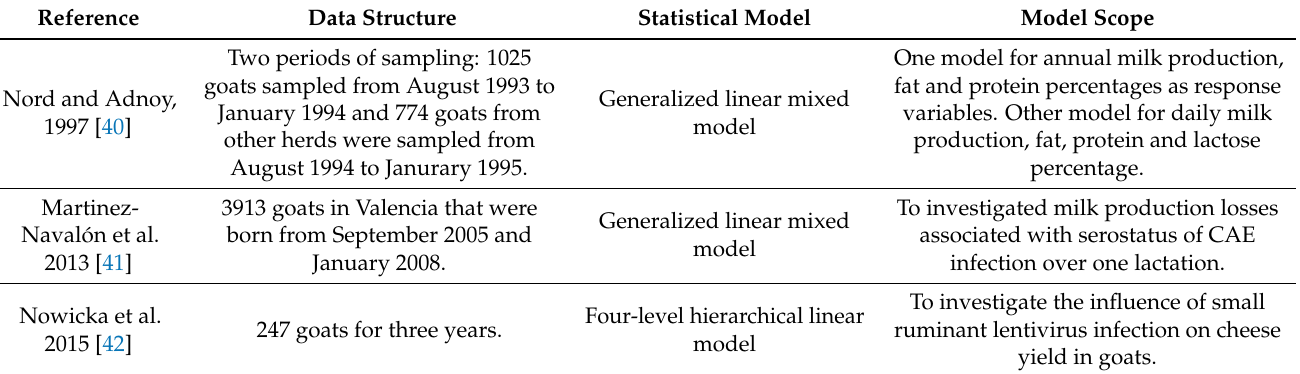
Table 2. Articles that modelled the effects of CAE into dairy products quality and